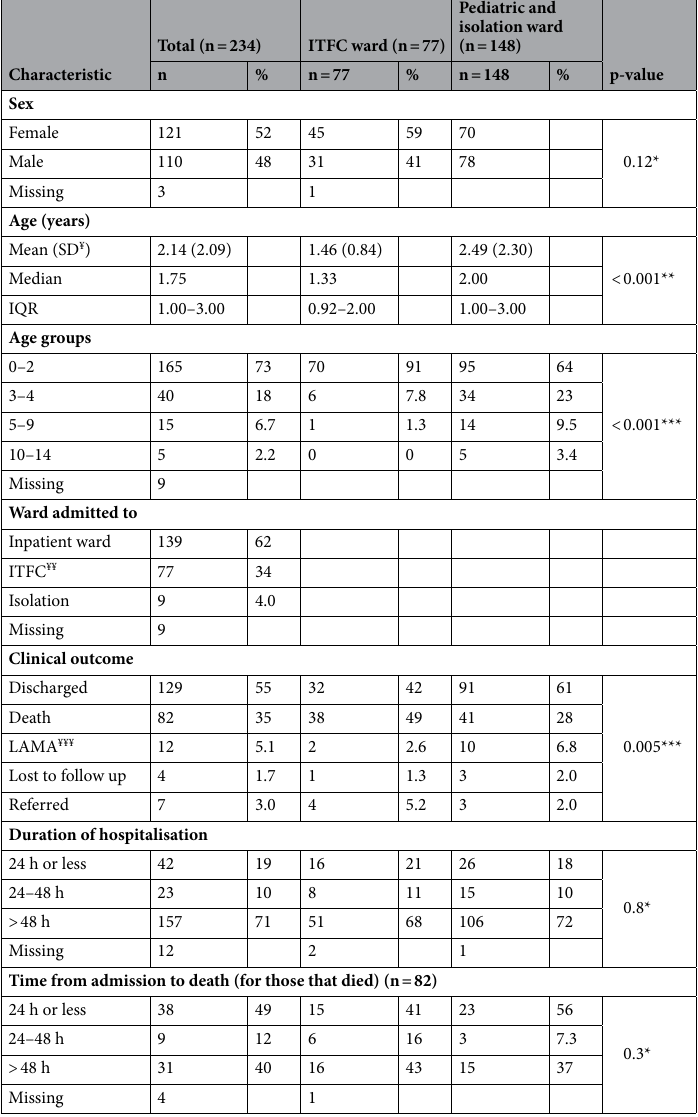
of age, compared to 64% in the pediatric/isolation ward (p < 0.001). ITFC patients also had a significantly higher mortality rate compared to those in the pediatric and isolation ward (49% vs. 28%) (Table 1).